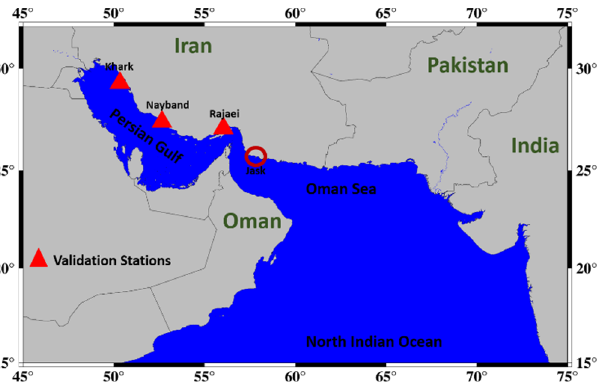
Figure 7. The validation stations, along with the map of locations mentioned in the study area.